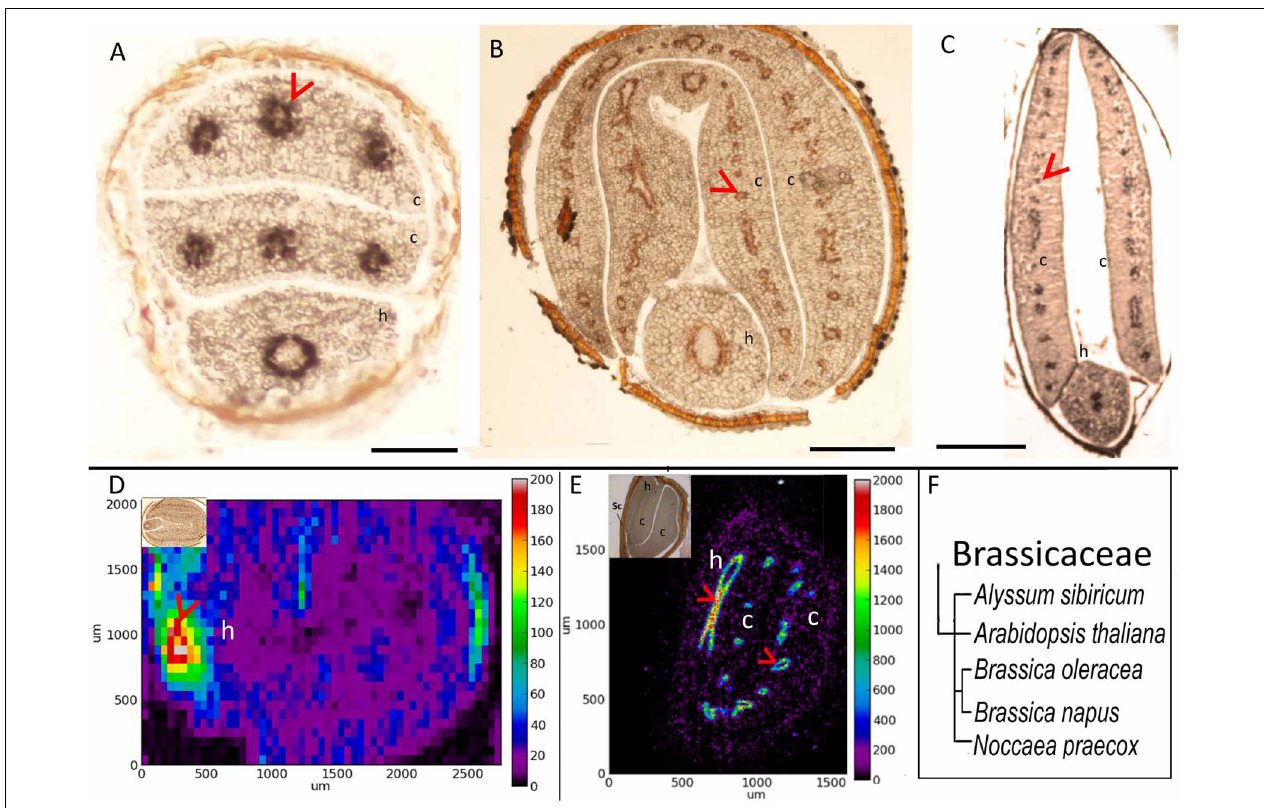
FIGURE 1 | Fe accumulates in the endodermis of Brassicaceae family. (A–C) Perls/DAB-stained seed cross sections. Cross sections were stained with Perls/DAB and observed under light microscope. From left to right: Arabidopsis thaliana , Brassica oleracea , and Alyssum sibiricum . Brown regions surrounding the embryos are seed coats. These were already brown before the staining; thus, the color does not reflect the stained Fe. Fe appeared as black stains in panels (A) and (C) , and brown in panel (B) . Circular-shaped staining in Arabidopsis thaliana corresponds to the endodermal cells surrounding the provascular strands. (D,E) Synchrotron X-Ray fluorescence images of relative Fe distribution in the seeds. (D) Brassica napus and (E) Noccaea praecox. (F) Branch of the taxonomic tree, for the whole tree refer to Figure 8 . This branch shows species that were examined for Fe reserves in Brassicaceae family and used as a visual aid. Note that Arabidopsis thaliana , Alyssum sibiricum , and Noccaea praecox , consist of a single pair of cotyledons, but both Brassica napus and Brassica oleracea consist of a pair of inner and an outer cotyledons. Bar represents 0.1 mm in panel (A) , 0.5 mm in panels (B,C) . c, cotyledon; h, hypocotyl. Red arrow heads point to examples of specific